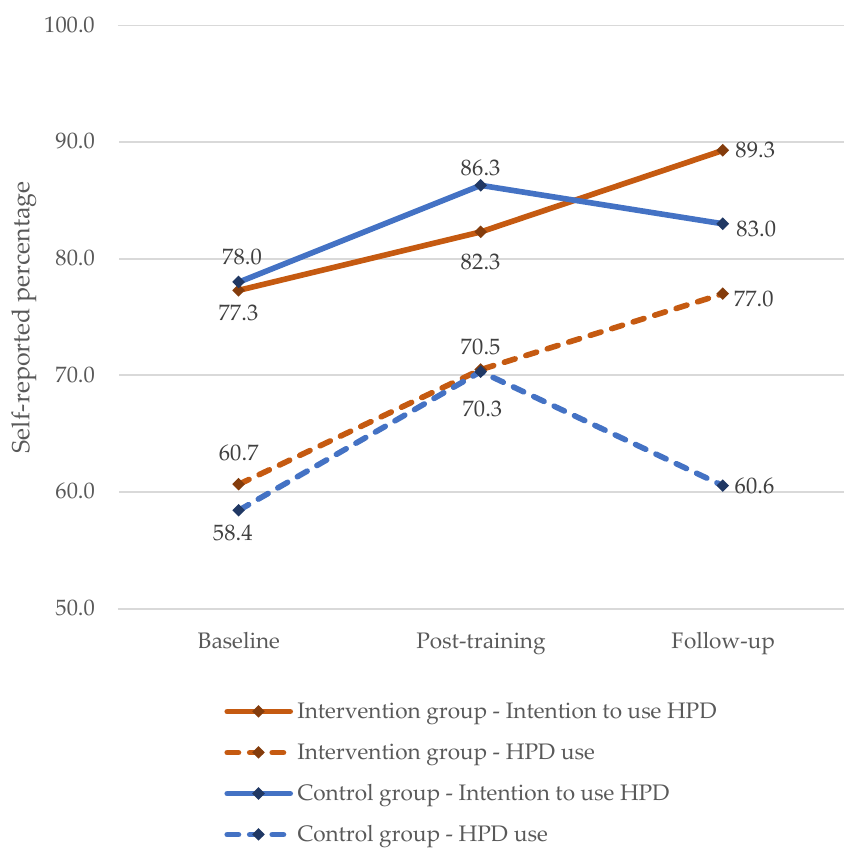
Figure 2. HPD use and intention to use HPD over time.